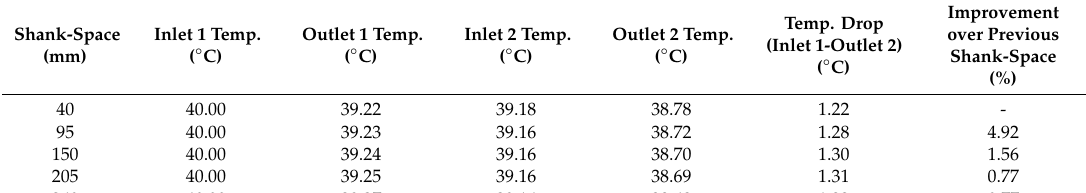
Table 3. Simulation results for di ff erent shank-spaces for the 40 m borehole. Shank-Space (mm)